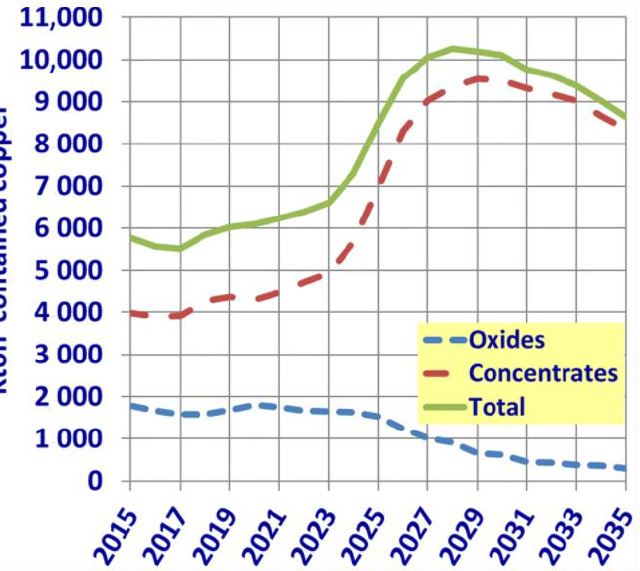
Figure 3. Projection of copper production in Chile in the coming years from oxide and sulfide (concentrate) ores (Adapted from [5] with permission).